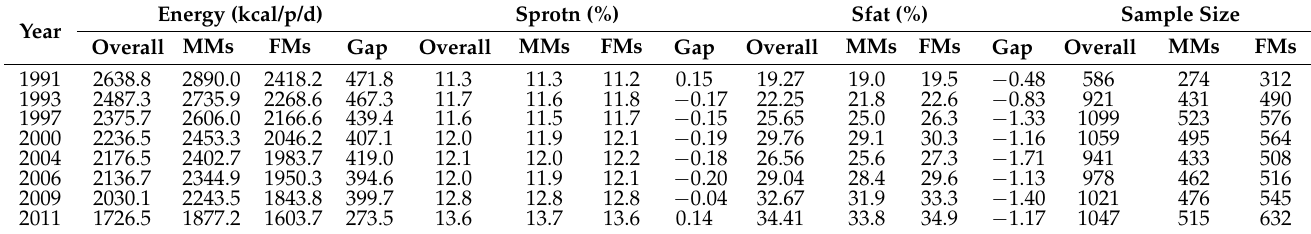
Table 3. Changes of average nutritional intake for migrants over